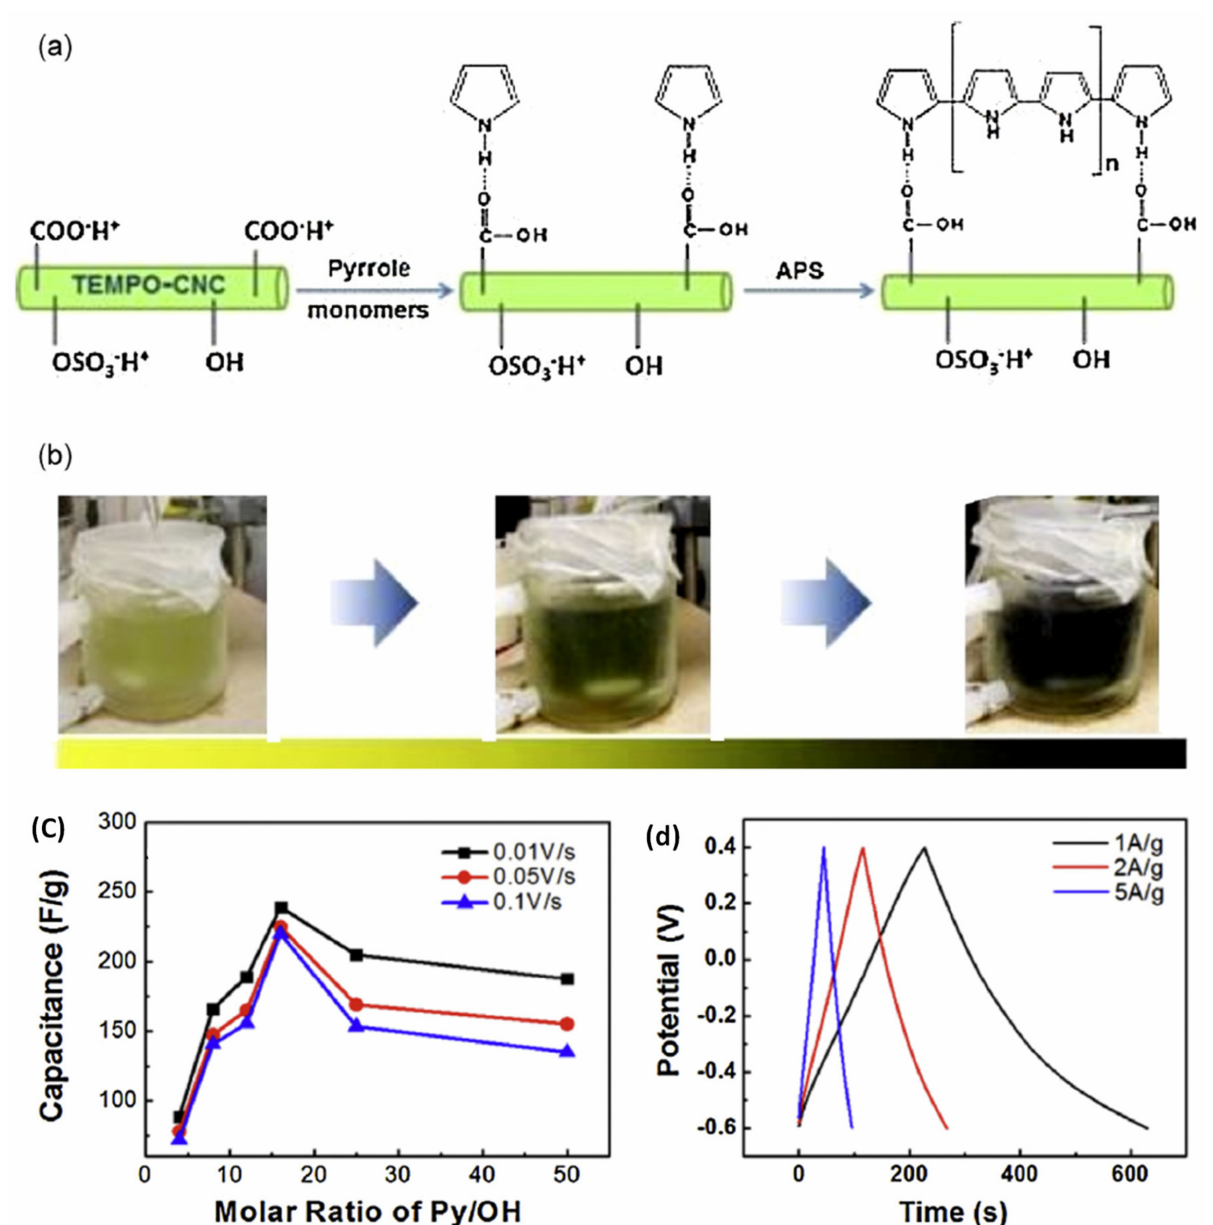
Figure 7. ( a , b ) In situ polymerization synthesis of CNC/PPy, ( c ) Effect of PPy on the capacitance of CNC/PPy, ( d ) Charge and discharge test of CNC/PPy at 1 Ag − 1 , 2 Ag − 1 and 5 Ag − 1 (charge current). Adapted with permission from [102]. Copyright 2014